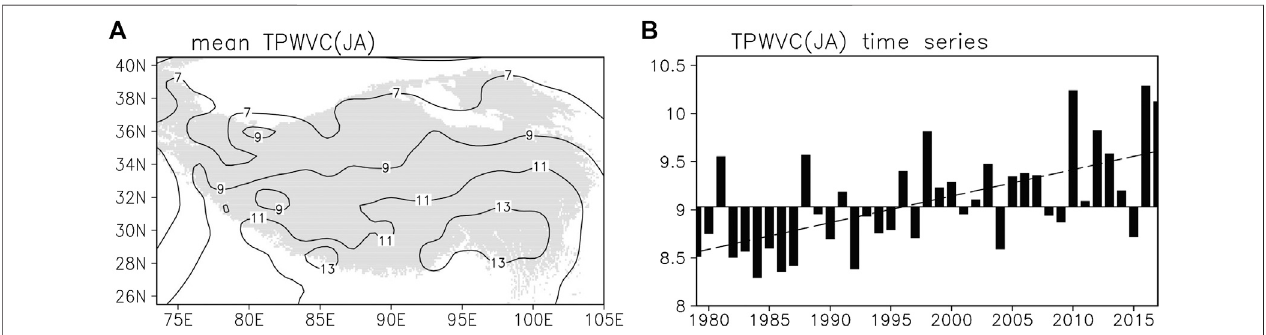
FIGURE 1 | (A) Water vapor content over the Tibetan Plateau (TPWVC) at mean state in summer (unit: mm/day), and (B) the corresponding time series averaged TPWVC (solid line indicates the average for 35 years and dashed line indicates the trend. unit: mm). Shaded areas in (A) indicate the Tibetan Plateau.